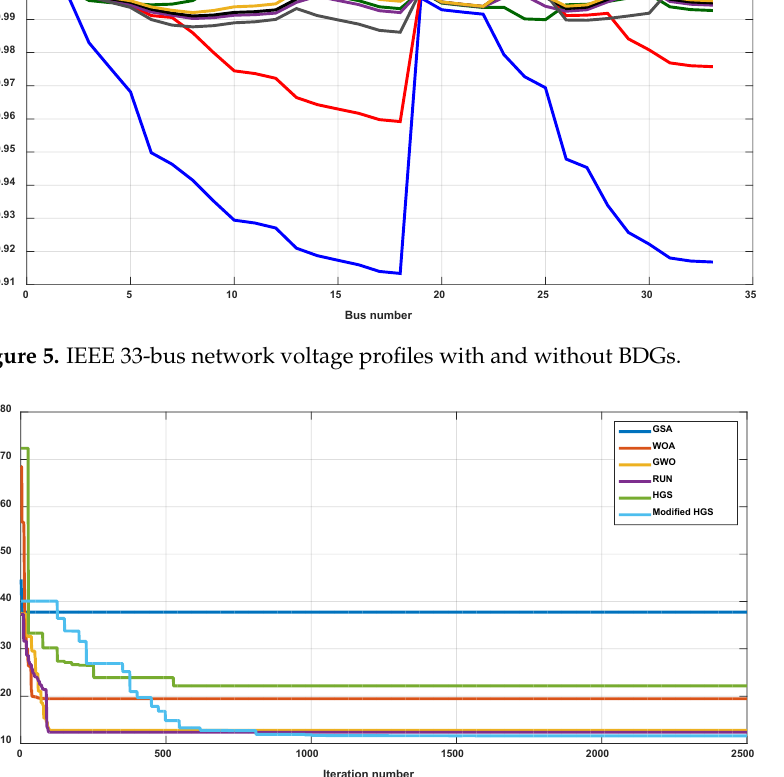
Figure 6. Variation in power loss with iteration numbers of different optimizers applied to the IEEE 33-bus.